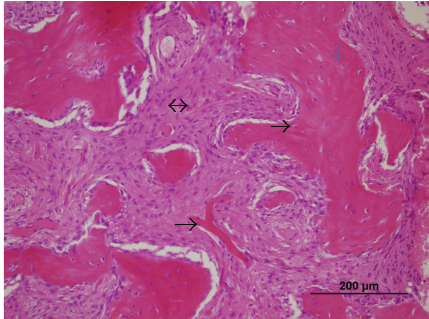
Figure 5: Histopathology demonstrates immature bone anasto- mosis, forming at the fibrous stroma rich of cellular and vascular structure. Vascular structure (black arrow), osteocyte (small black arrow), osteoid matrix (blue arrow), and fibrous stroma (two-sided arrow) are shown (HE ×